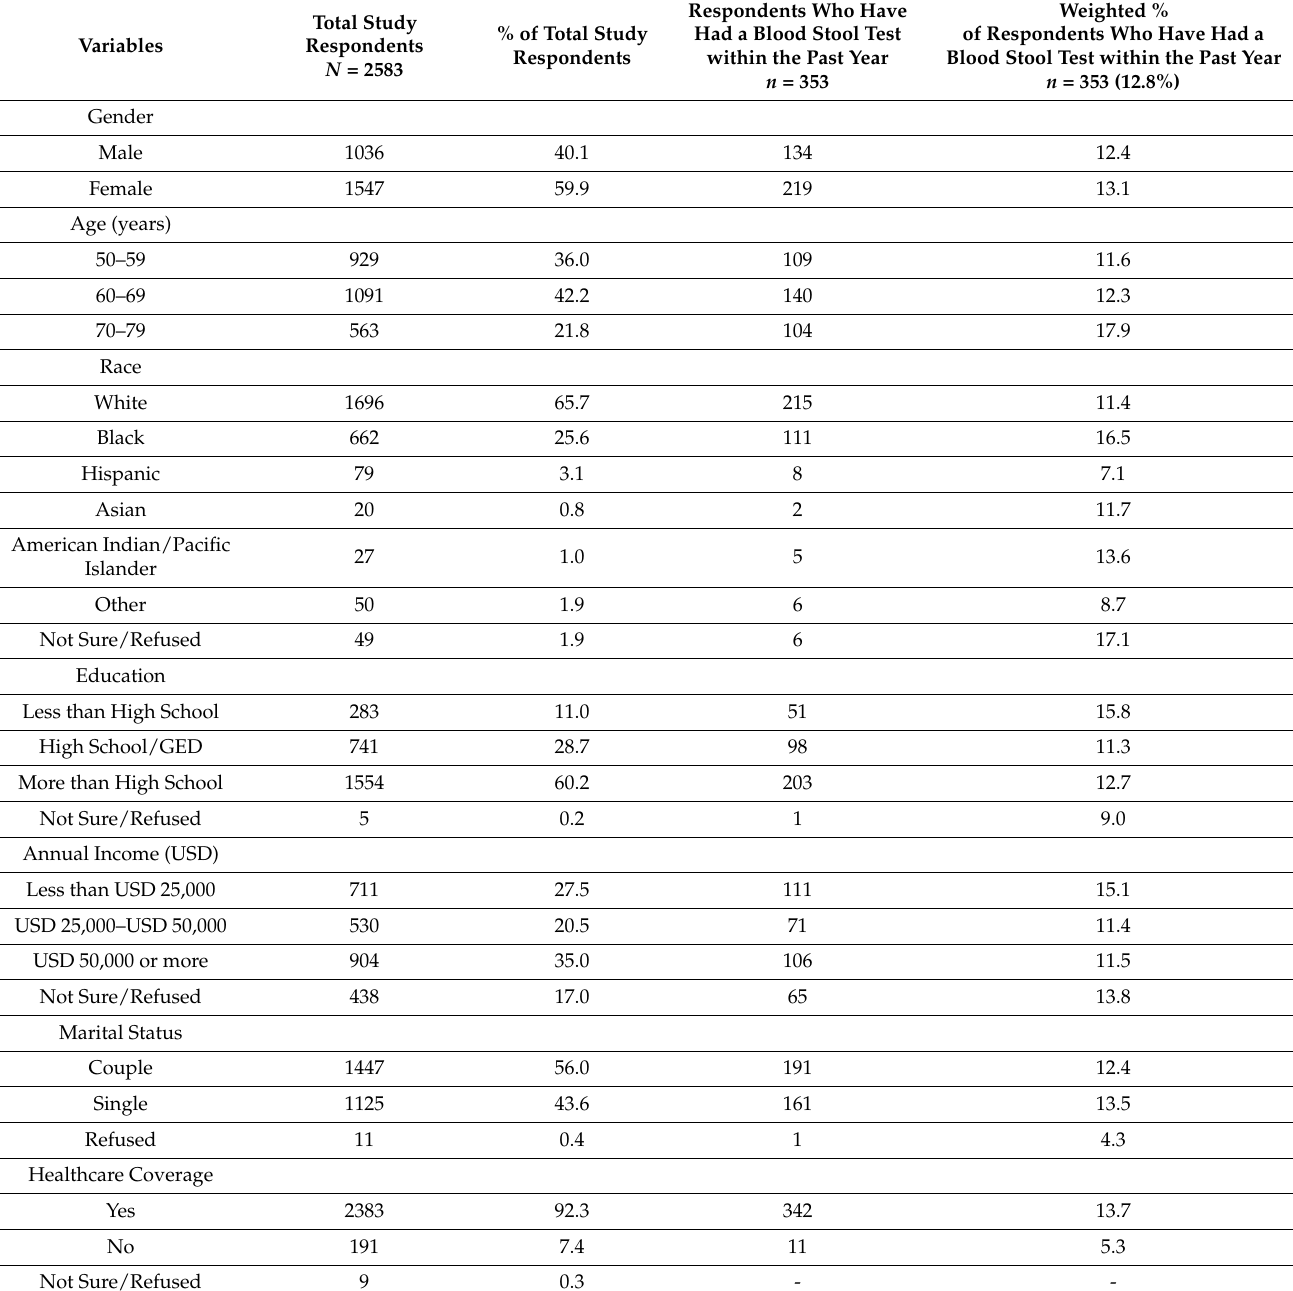
Table 2. Sociodemographics of respondents to the question “if you had a blood stool test within the past year” in Georgia: 2016 BRFSS